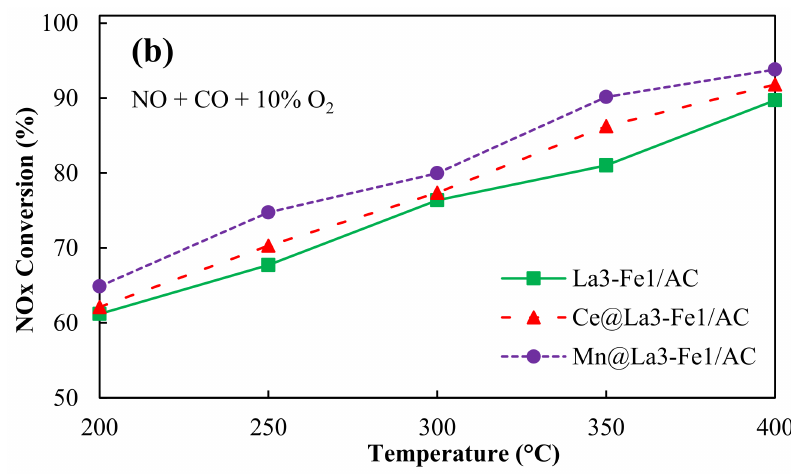
Figure 8. NO x conversion over promoted La3-Fe1 / AC catalysts ( a ) in the absence of oxygen and ( b ) in the presence of oxygen, reaction conditions: NO = 250 ppm, CO = 5000 ppm, total flow rate: 350 mL / min; Temperature: 200–400 ◦ C, catalyst: 200 mg, GHSV = 26,000 h − 1